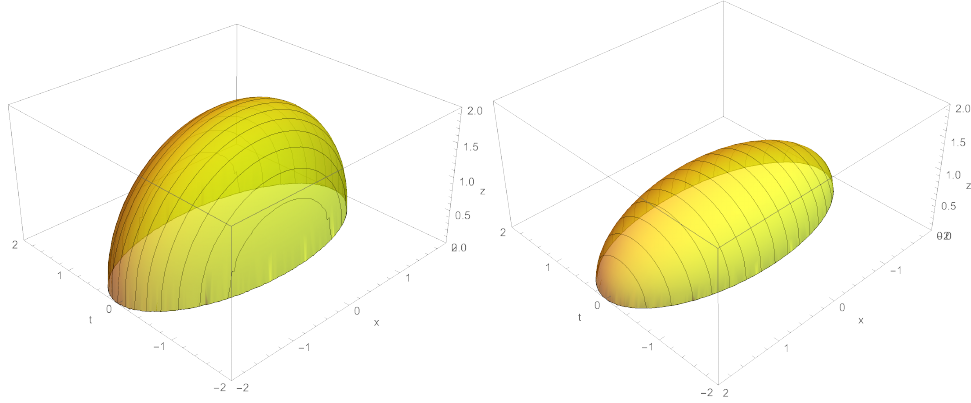
Figure 12: Two hypersurfaces satisfying (71) with the same boundary condition at z = 0. For the solution on the left, we find K < 0 everywhere, while for the one on the right we find K > 0